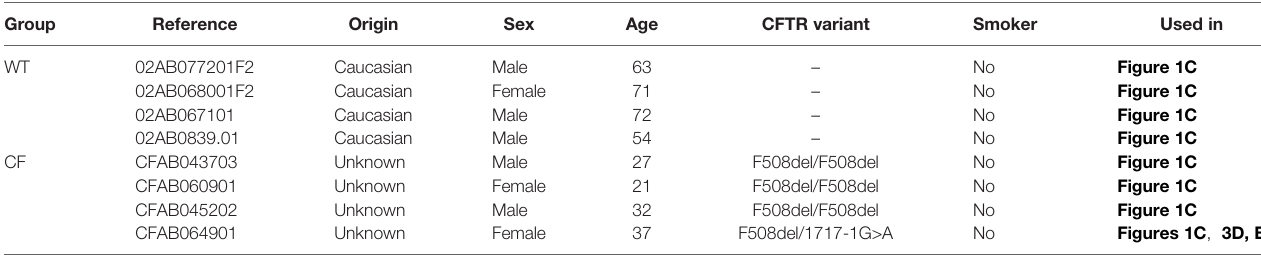
TABLE 1 | Characteristics of donors of bronchial epithelial